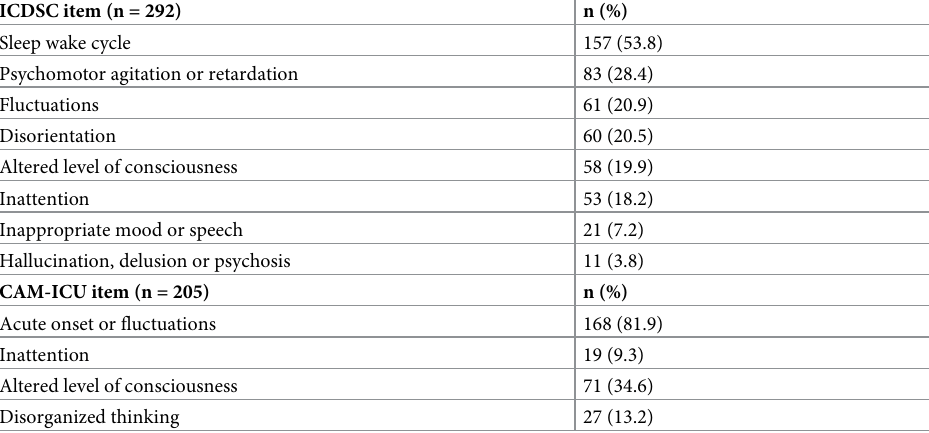
Table 3. Frequency of ICDSC items reported in patients with less than clinical threshold symptoms of delirium (n =